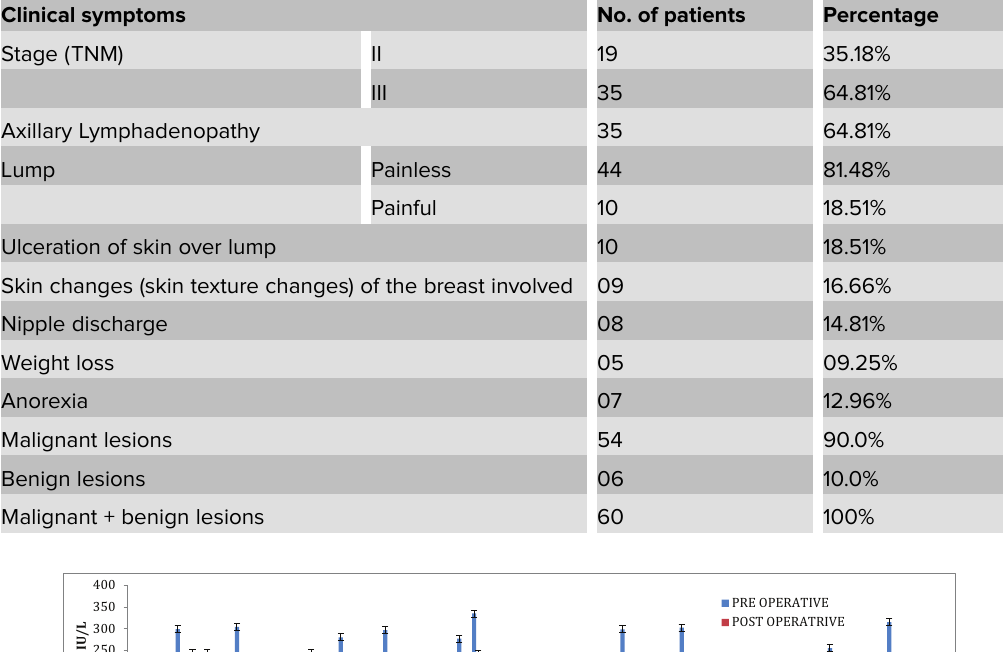
Table 2: Distribution of breast cancer patients according to their symptoms.